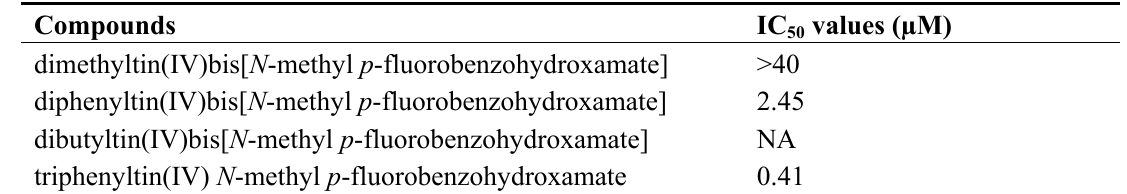
values of organotins on HCT116 Table 3. IC 50